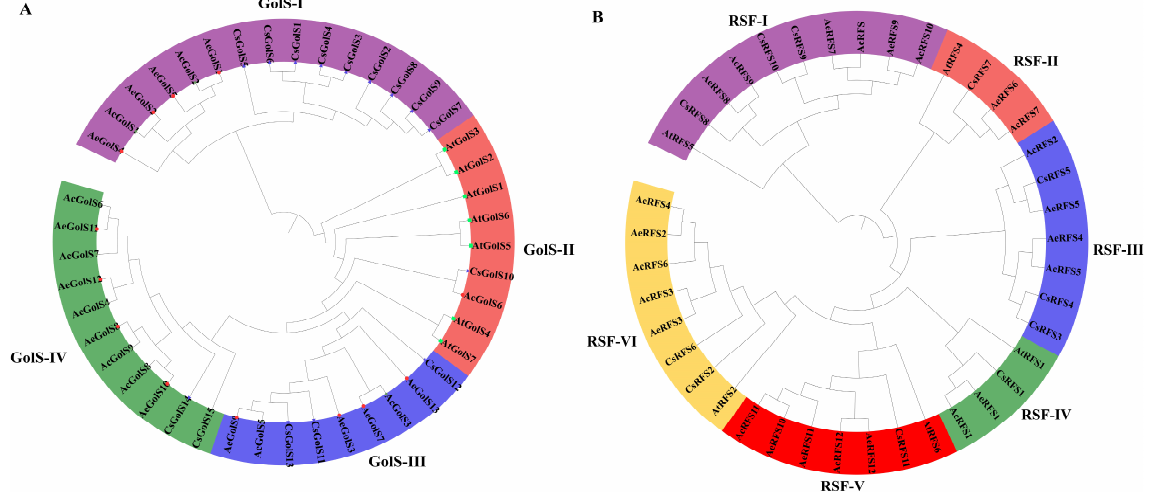
Figure 1. Phylogenetic analysis of kiwifruit and other species GolS and RFS proteins. The phylogenetic trees were conducted based on the full-length amino acid sequences using MEGA 6.0 by the neighbor-joining method with 1000 bootstrap replicates. ( A ) The deduced full length amino acid sequences of A. chinensis ( AcGolS ), A. eriantha ( AeGolS ), C. sinensis ( CsGolS ) and A. thaliana ( AcGolS ) were used for phylogenetic tree construction. ( B ) The deduced full length amino acid sequences of A. chinensis ( AcRFS ), A. eriantha ( AeRFS ), C. sinensis ( CsRFS ) and A. thaliana ( AcRFS ) were used for phylogenetic tree construction.